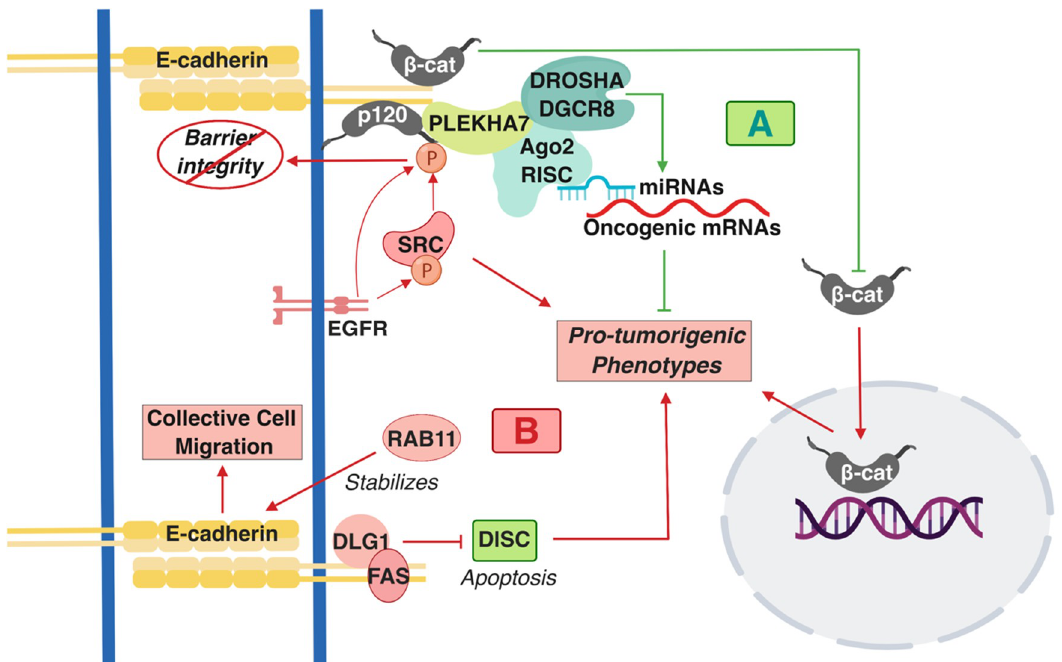
Figure 1. A summary of the pro- and anti-tumorigenic signaling mediated by E-cadherin-based Adherens Junctions AJ complexes that has been described in colon cells and tissues. ( A ) Shades of green/blue depict tumor-suppressing components and functions, whereas ( B ) shades of red represent the tumor-promoting ones described in the text. T-arrows represent inhibition of molecules or pro-tumorigenic signaling processes; straight arrows represent activation of molecules or pro-tumorigenic signaling processes. β-cat: β-catenin; p120: p120 catenin; RISC: RNA-induced silencing complex.